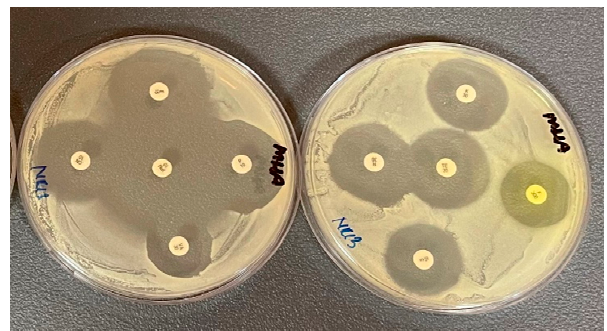
Figure 4. The images of disk diffusion assay on S. aureus.